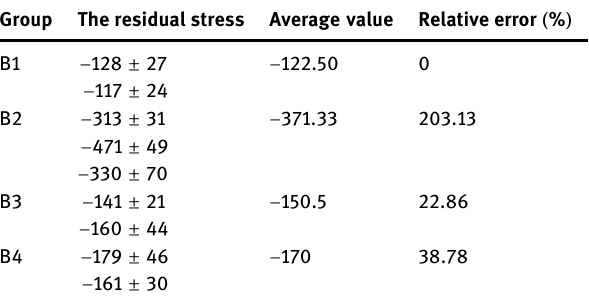
Group The residual stress Average value Relative error ( %